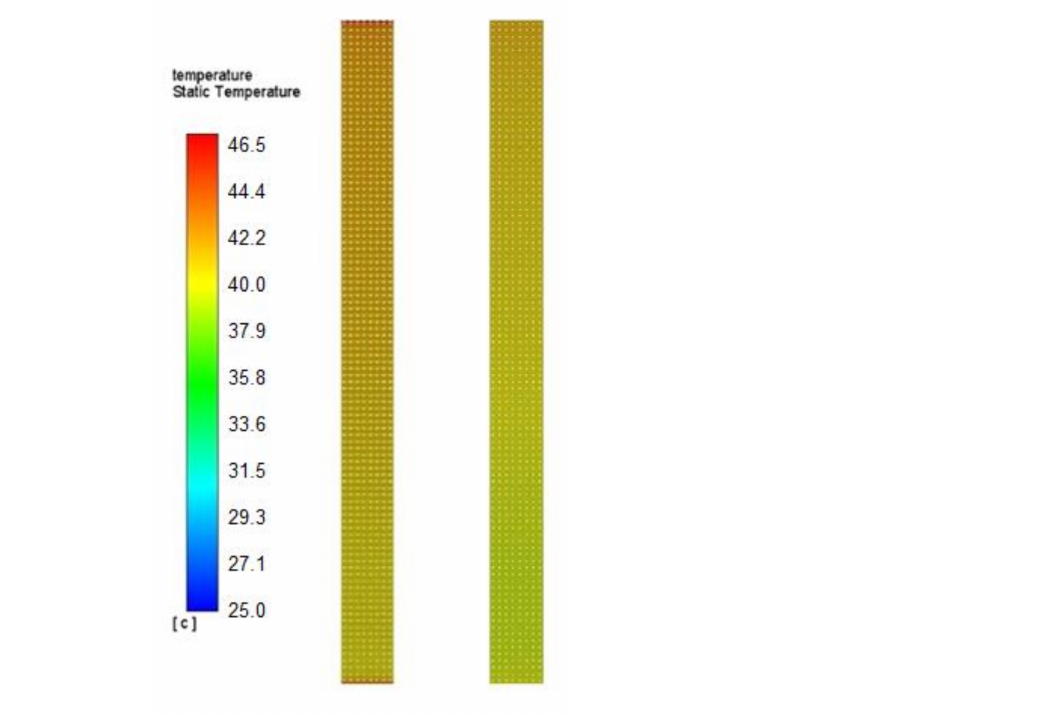
Figure 20. Distribution of the temperature on the perforated absorber plate of the HDPE ( left ) and Aluminum ( right ) with an air flow of 500 m 3